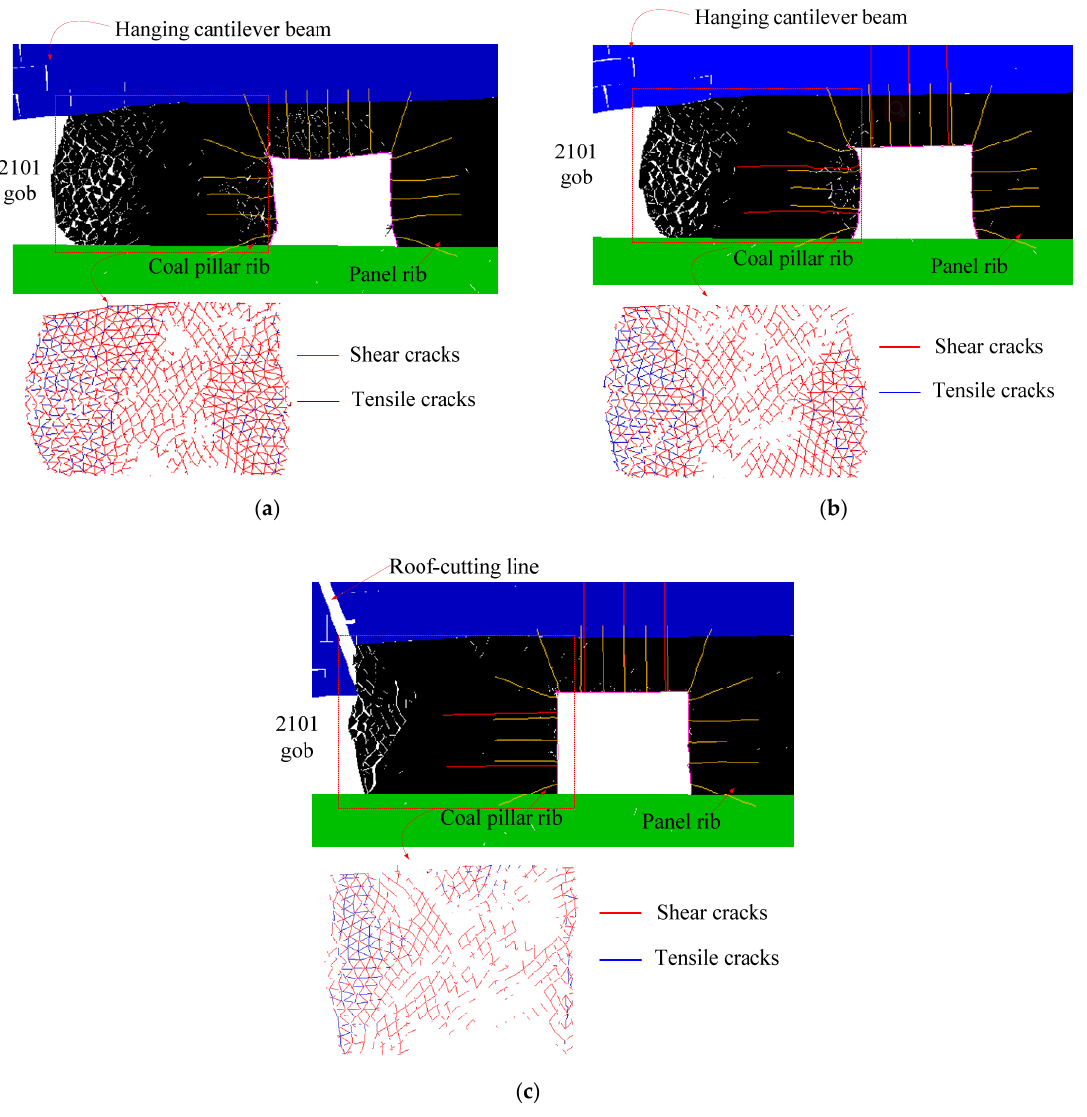
Figure 13. The failure patterns and cracks evolution in the coal pillar. ( a ) Primary support; ( b ) optimized support; ( c ) reinforced-support support + roof-cutting.